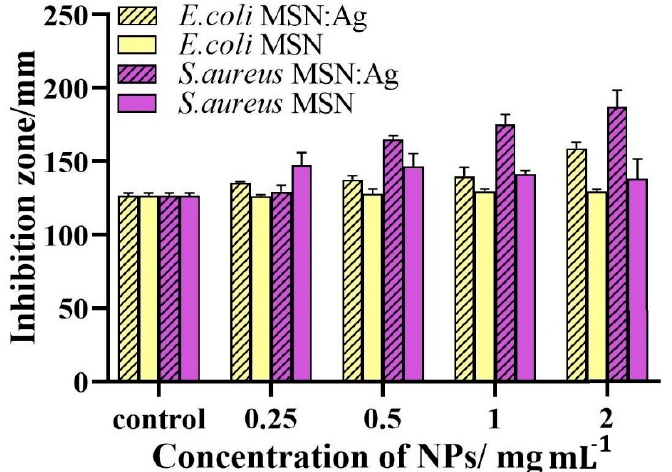
Figure 5. The zones of inhibition generated by MSN/Ag and MSNs against E. coli and S. aureus tested at different concentrations after 16 h incubation. Each data point represents an average of three parallel samples, and the error bars indicate 1 standard deviation from the mean.